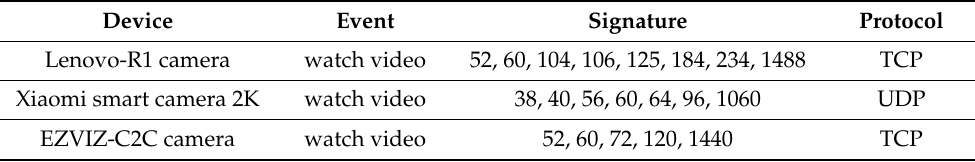
Table 8. Device event signature in the